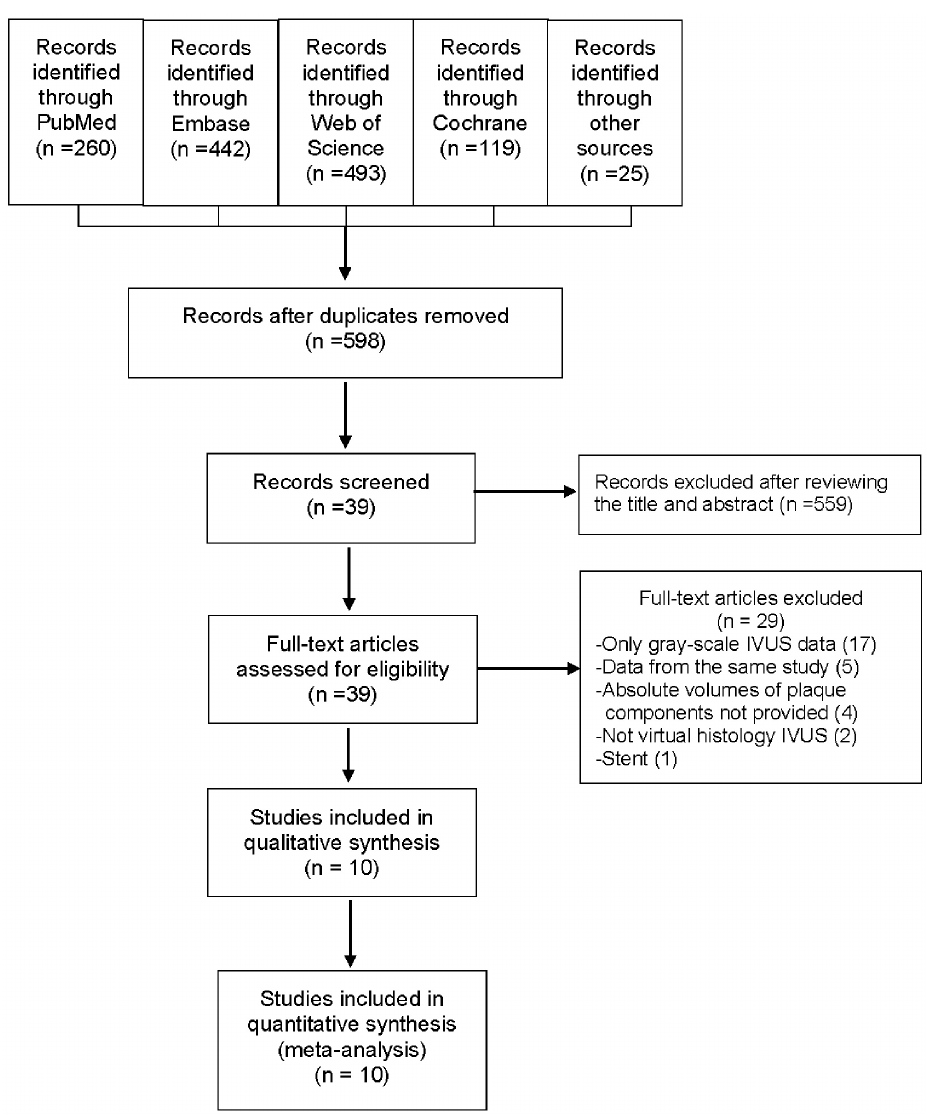
Fig 1. Flow diagram showing the selection of studies for the meta-analysis. Abbreviations: IVUS: intravascular ultrasound.